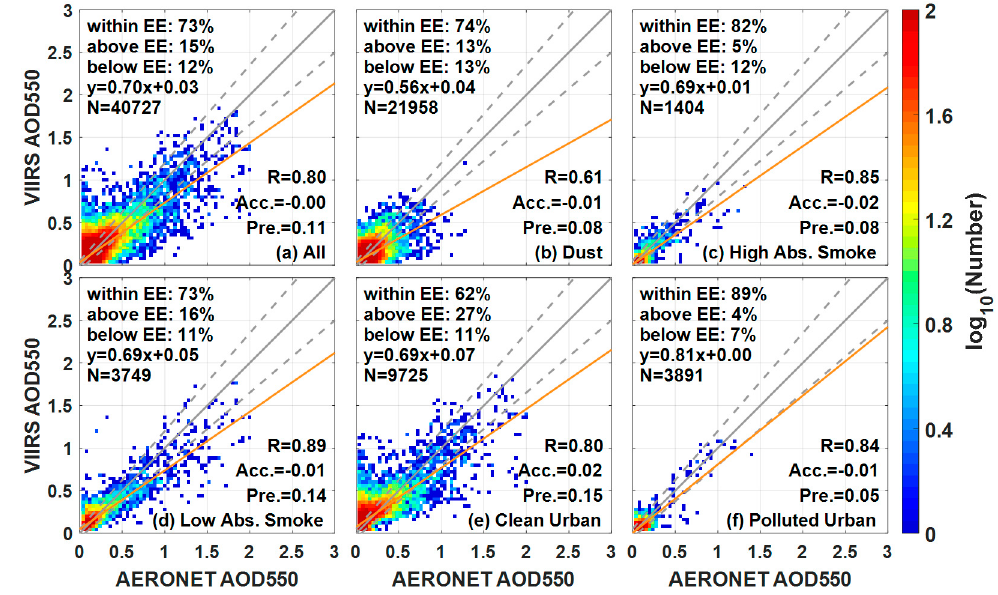
Figure 6. Scatterplots of VIIRS AOD550 against AERONET measurements under different VIIRS aerosol types: ( a ) All; ( b ) dust; ( c ) High Absorption Smoke; ( d ) Low Absorption Smoke; ( e ) Clean Urban and ( f ) Polluted Urban. The width of each pixel is 0.04, and the number of collocations that falls within/above/below EE is represented in each figure. The yellow line is the regression line, the gray solid line is the 1:1 line, and the gray dashed lines are the EE envelopes. Abbreviation in this figure: expected error (EE), accuracy (Acc.) and precision (Pre.).